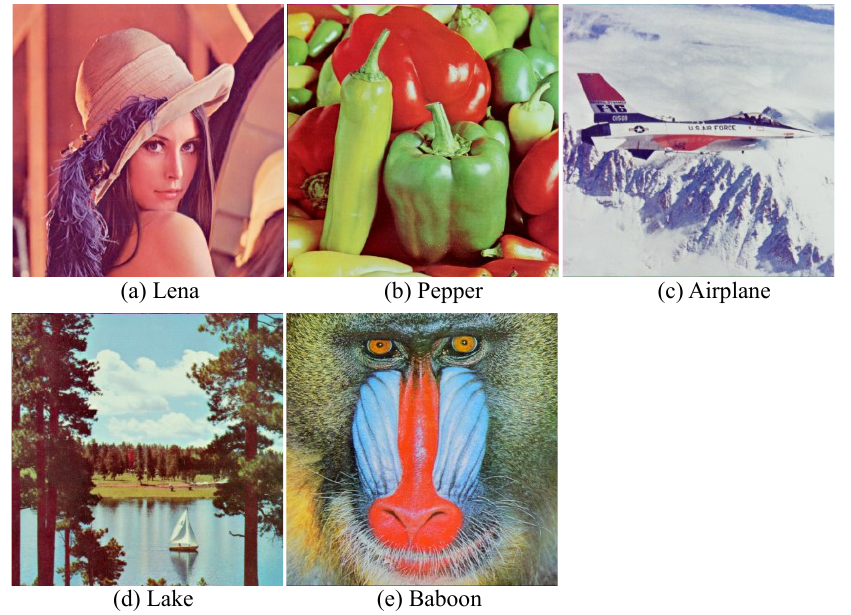
Figure 6. Original image used in the experiment; ( a ) Lena, ( b ) Pepper, ( c ) Airplane, ( d ) Lake, and ( e )